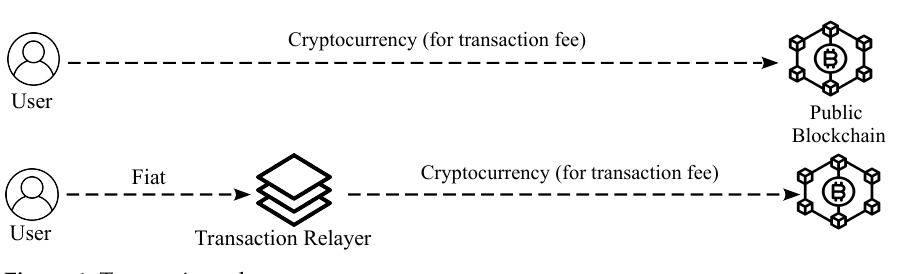
Figure 1. Transaction